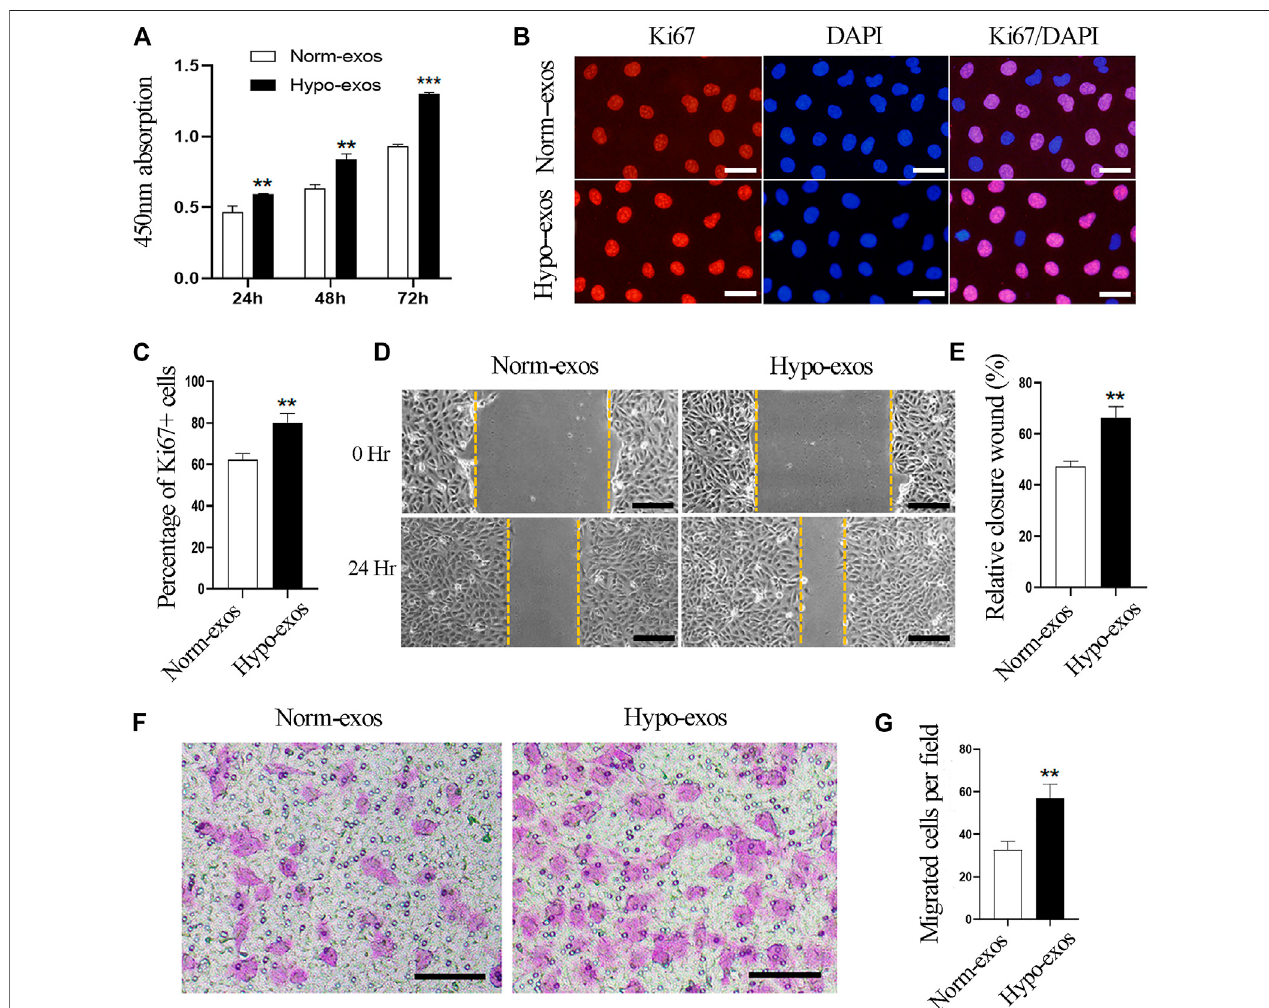
FIGURE 2 | Hypo-exos signi fi cantly enhance the growth and migration of endothelial cells in vitro compared with Norm-exos. (A) Effects of Hypo-exos and Norm- exos on the viability of endothelial cells analyzed using the CCK-8 assay. (B) Effects of Hypo-exos and Norm-exos on the proliferation of endothelial cells assessed by immuno fl uorescencestainingofKi67;scalebars=100 μ m. (C) PercentageofKi67-positivecells(%)quanti fi edin (B) . (D) Signi fi cantlyincreasedclosureofthescratched area in Hypo-exos treated group was observed in wound healing assays; scale bars = 200 μ m. (E) Quanti fi cation of the rate of scratch closure (%) in (D) . (F) Signi fi cantly higher number of endothelial cells in Hypo-exos group migrated to the bottom than Norm-exos group veri fi ed by Transwell migration assays; scale bars = 200 μ m. (G) Quanti fi cation of the number of migrated HUVECs in (F) . ** p < 0.01, *** p < 0.001.